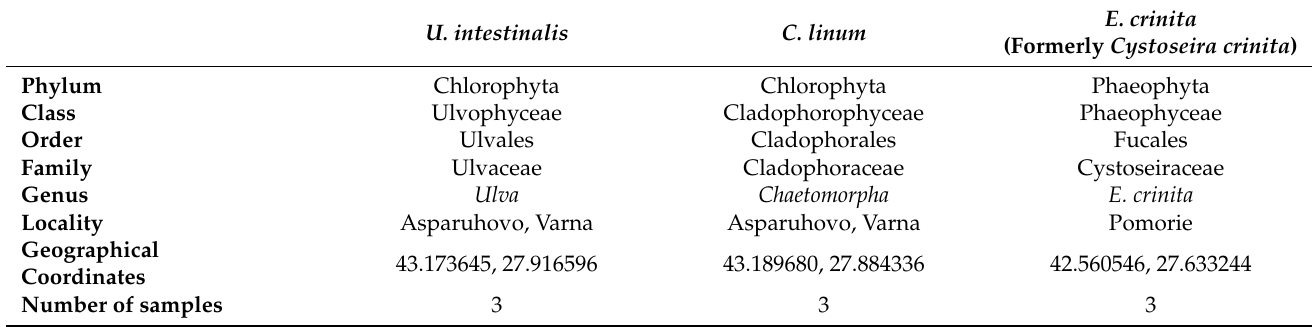
Table 4. Taxonomy of investigated marine